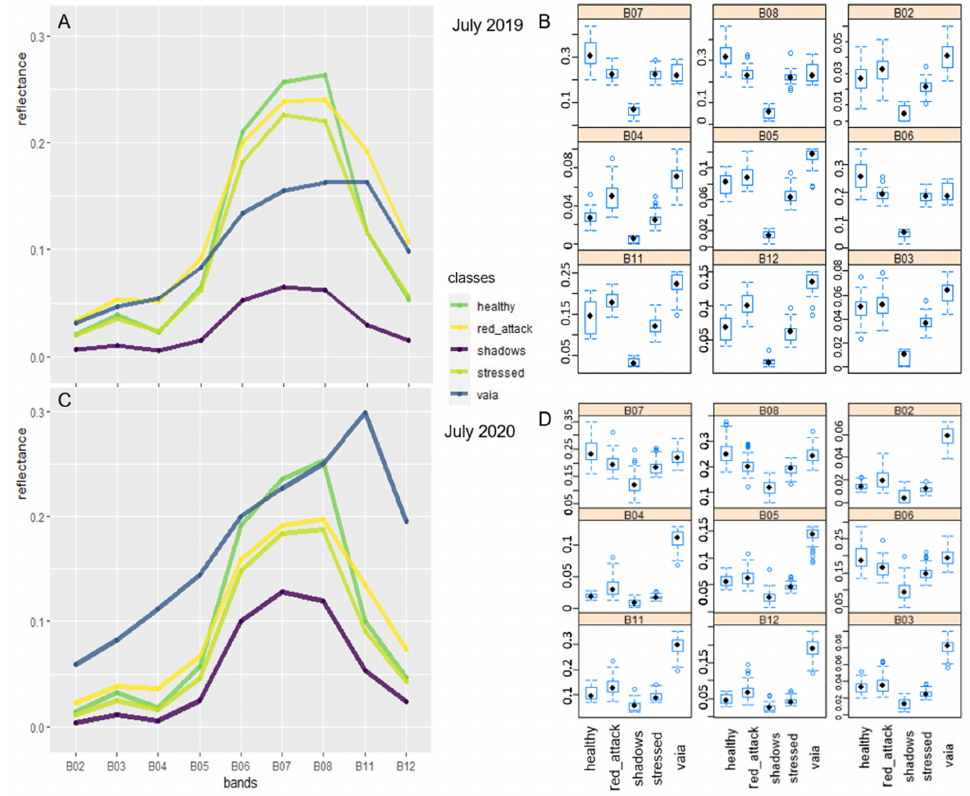
Figure 7. Mean spectral profiles from training site classes for each band ( A ) and ( C ) and variation per class for each band ( B ) and ( D ) in July 2019 and July 2020 for forest cover classes of healthy vegetation, stands in the bark beetle “red-attack” stage, shadows, stressed forest stands and Vaia- storm-related windthrows.